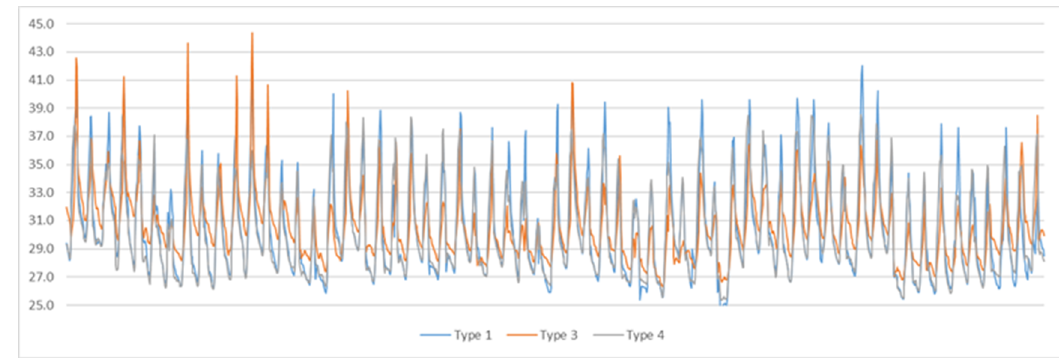
Figure 7. Hourly distribution of outdoor temperature in three shophouse urban types 1, 3, and 4.